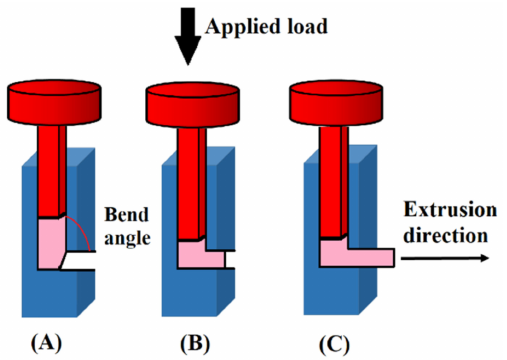
Figure 2. A schematic showing the working details of the equal-channel angular press (ECAP) process; first ( A ), intermediate ( B ), and final ( C )